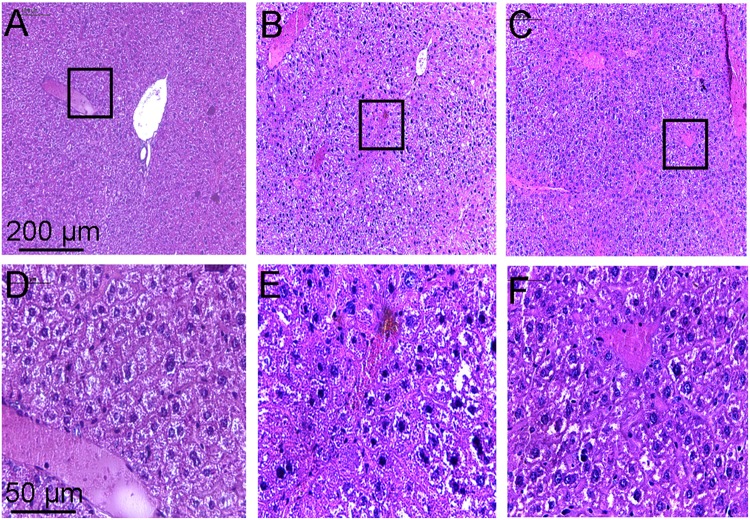
Inhibitory effect of toddalolactone on CCl4-induced liver fibrosis. (A,D) Healthy control group; (B,F) Model group; (C,F) Toddalolactone treatment group. Images in (A–C) are 100× magnification, whereas images in (D–F) are 400× magnification.